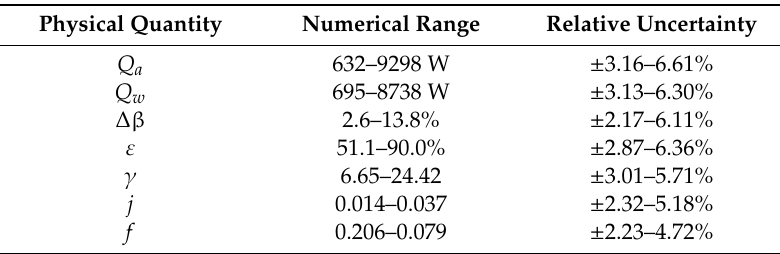
Table 2. Uncertainty of the main parameter variables.